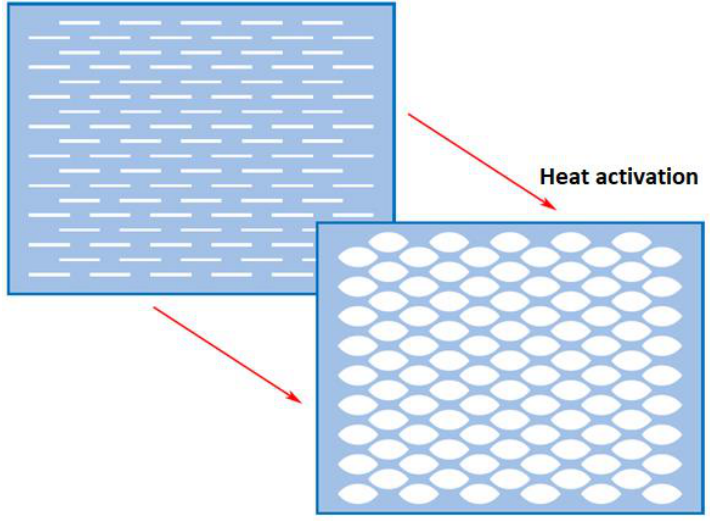
Figure 2. Heat e ff ect on the adhesive film (adapted from [33]). Figure 2. Heat effect on the adhesive film (adapted from [33]).